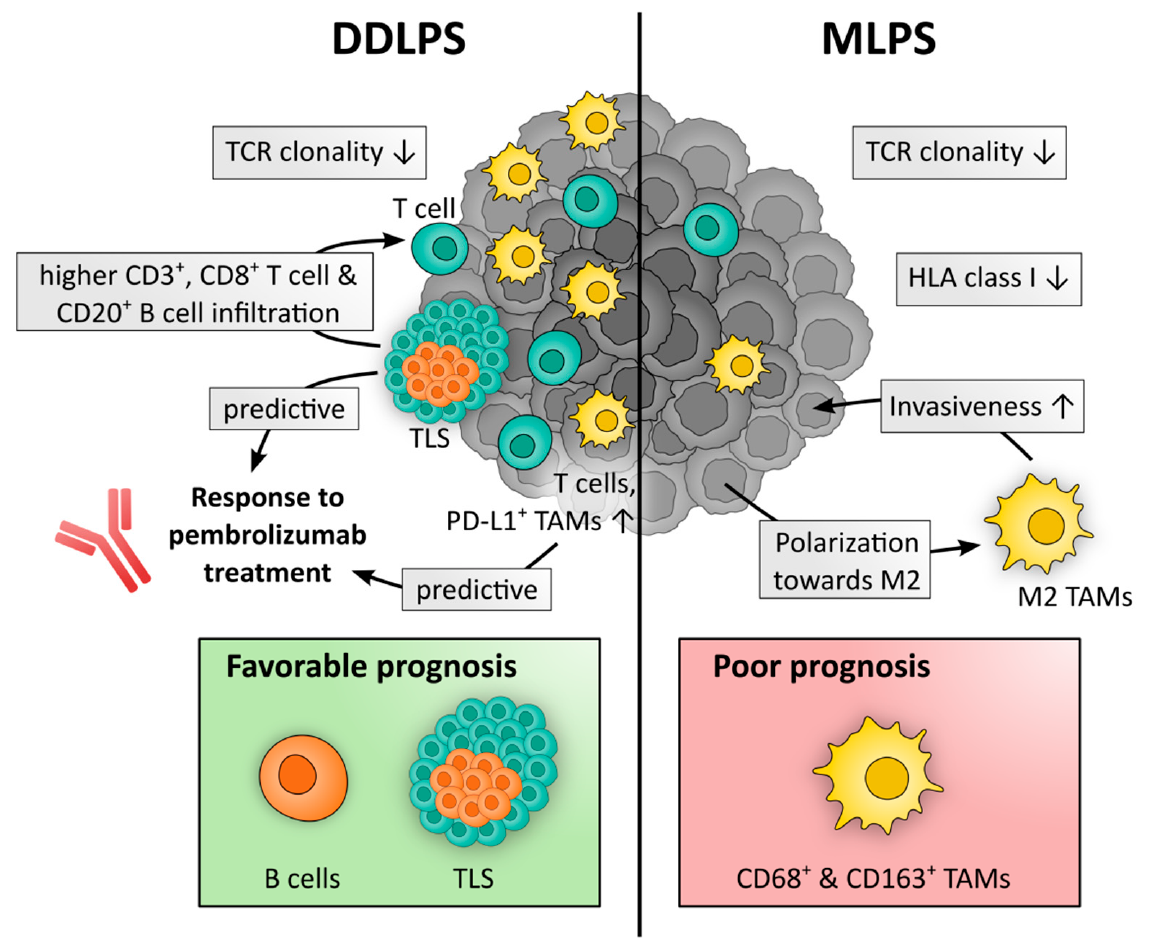
Figure 2. The histological LPS subtypes display different features of their immune contexture. Research mainly focuses on DDLPS and MLPS, whereas insights on the immune microenvironment of WDLPS and PLPS are scarce and lacking in the case of MPLPS. DDLPS is characterized by a higher infiltration of T cells and tumor-associated macrophages (TAMs) compared to MLPS and TAMs are outnumbering T cells in DDLPS while this was not observed in MLPS. Both subtypes exhibit low T cell receptor (TCR) clonality and additionally, MLPS tumors display low levels of human leukocyte antigen (HLA) class I expression. Response to pembrolizumab in DDLPS patients was correlated to a higher density of T cells and a higher proportion of PD-L1 + TAMs at baseline. Furthermore, the presence of tertiary lymphoid structures (TLS) in DDLPS is associated with response to pembrolizumab treatment and correlates with elevated infiltration levels of CD3 + and CD8 + T cells as well as CD20 + B cells. In MLPS, tumor cells can promote M2 polarization of TAMs which in turn can enhance the motility and invasiveness of MLPS cells. While several immune cell types are of undefined prognostic value in LPS, accumulating evidence suggests a link to positive prognosis for B cells and TLS in DDLPS and an association with negative prognosis for TAMs, both CD68 + and CD163 + , in MLPS.